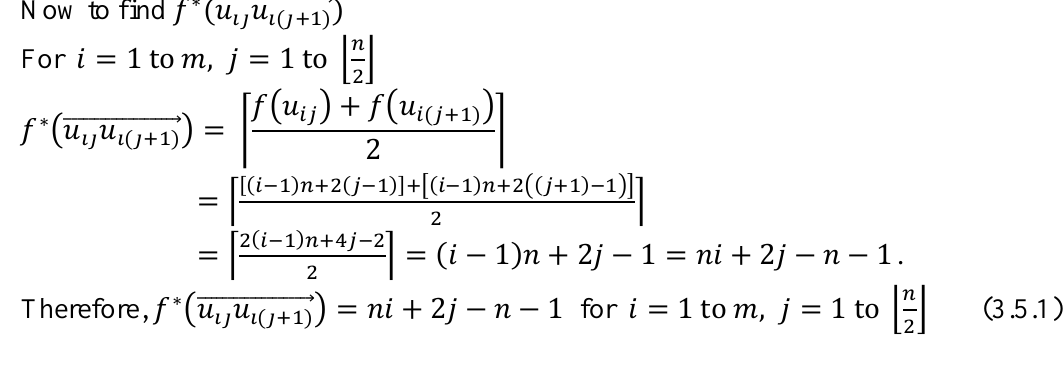
Figure 3.4: The labeling of the Di-cyclic Snake 𝑚𝐶